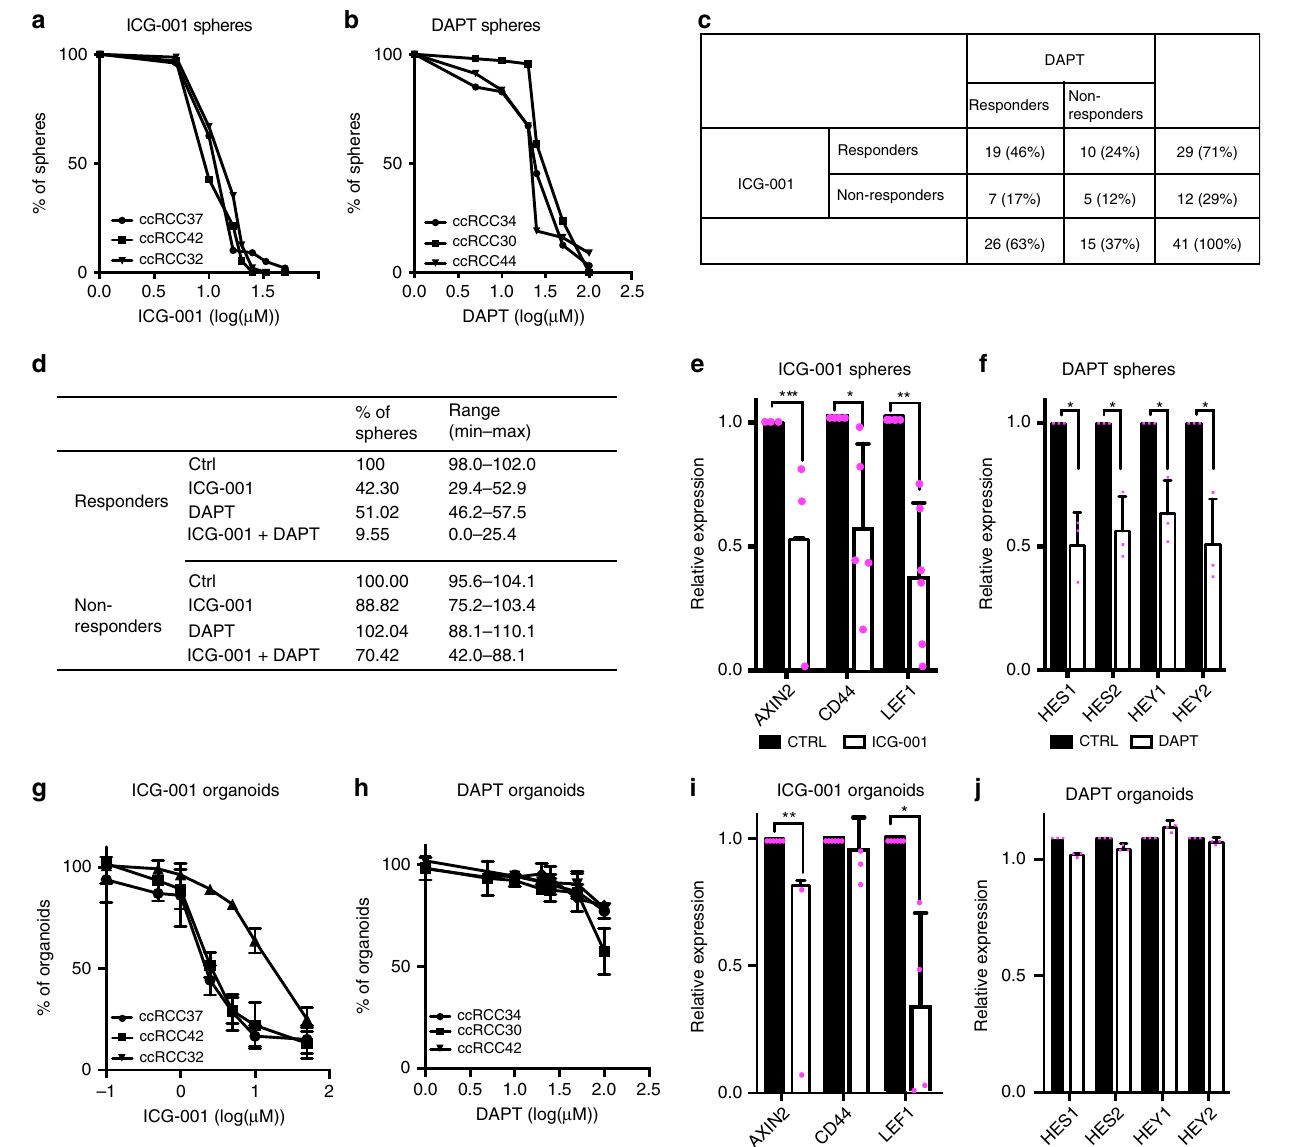
Fig. 6 Pharmacological inhibition of WNT and NOTCH signaling in ccRCC spheres and organoids. a , b ccRCC sphere cultures were treated with 5 – 50 µ M ICG-001 or 1 – 100 µ M DAPT for 7 days, and spheres <25 µ m were then counted. Data are shown for three exemplary cultures. Experiments were performed in 41 ccRCC sphere cultures. c Overview of DAPT and ICG-001 responders in 41 ccRCC spheres. Sphere cultures with ICG-001 IC50 < 20 µ M or DAPT IC50 < 30 µ M were classi fi ed as responders. d ICG-001 and DAPT responders or non-responders were treated with 20 µ M ICG-001, 20 µ M DAPT or both ( n = 5 for each treatment). Sphere numbers were counted after 7 days. e , f Sphere cultures treated with 20 µ M ICG-001 or 20 µ M DAPT ( n = 4 for each group), and the expression of target genes was measured by RT-qPCR. Data are shown as mean, error bars represent s.d. p -values: *<0.05, **<0.01, ***<0.001 by two-sided t -test. g , h ccRCC organoid cultures were treated with 0.1 – 50 µ M ICG-001 or 1 – 100 µ M DAPT for 7 days. Metabolic activity was measured by CellTiterGlo assay and normalized to vehicle-treated controls. Data are shown for three exemplary cultures as mean ± SD of three technical replicates. Experiments were performed in 15 organoid cultures. i , j Organoid cultures were treated with 5 µ M ICG-001 or 25 µ M DAPT, and the expression of target genes was measured by RT-qPCR ( n = 3 independent patients). Data are shown as mean, error bars represent s.d., p -values: *<0.05, **<0.01 by two-sided t